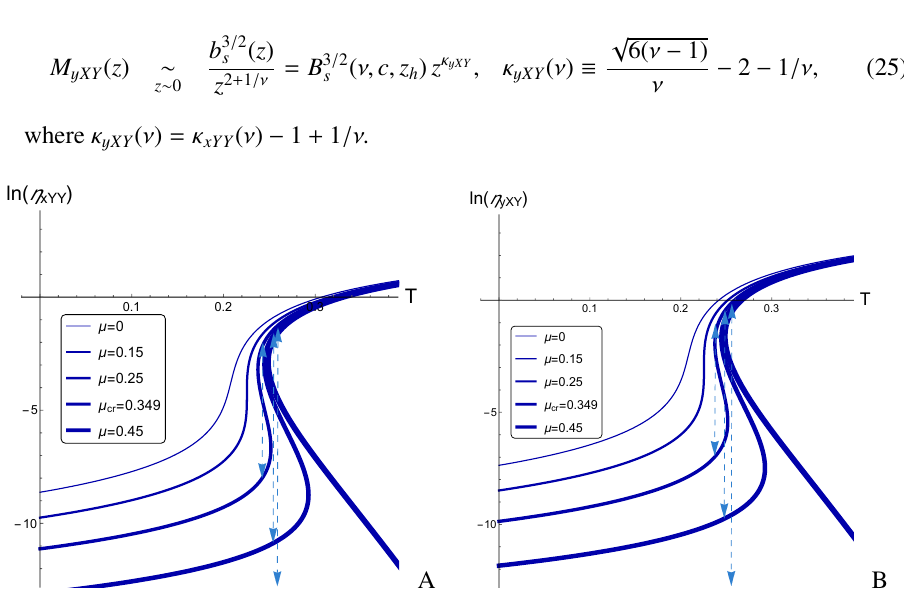
1, ν = 4 . 5 and di ff erent chemical −